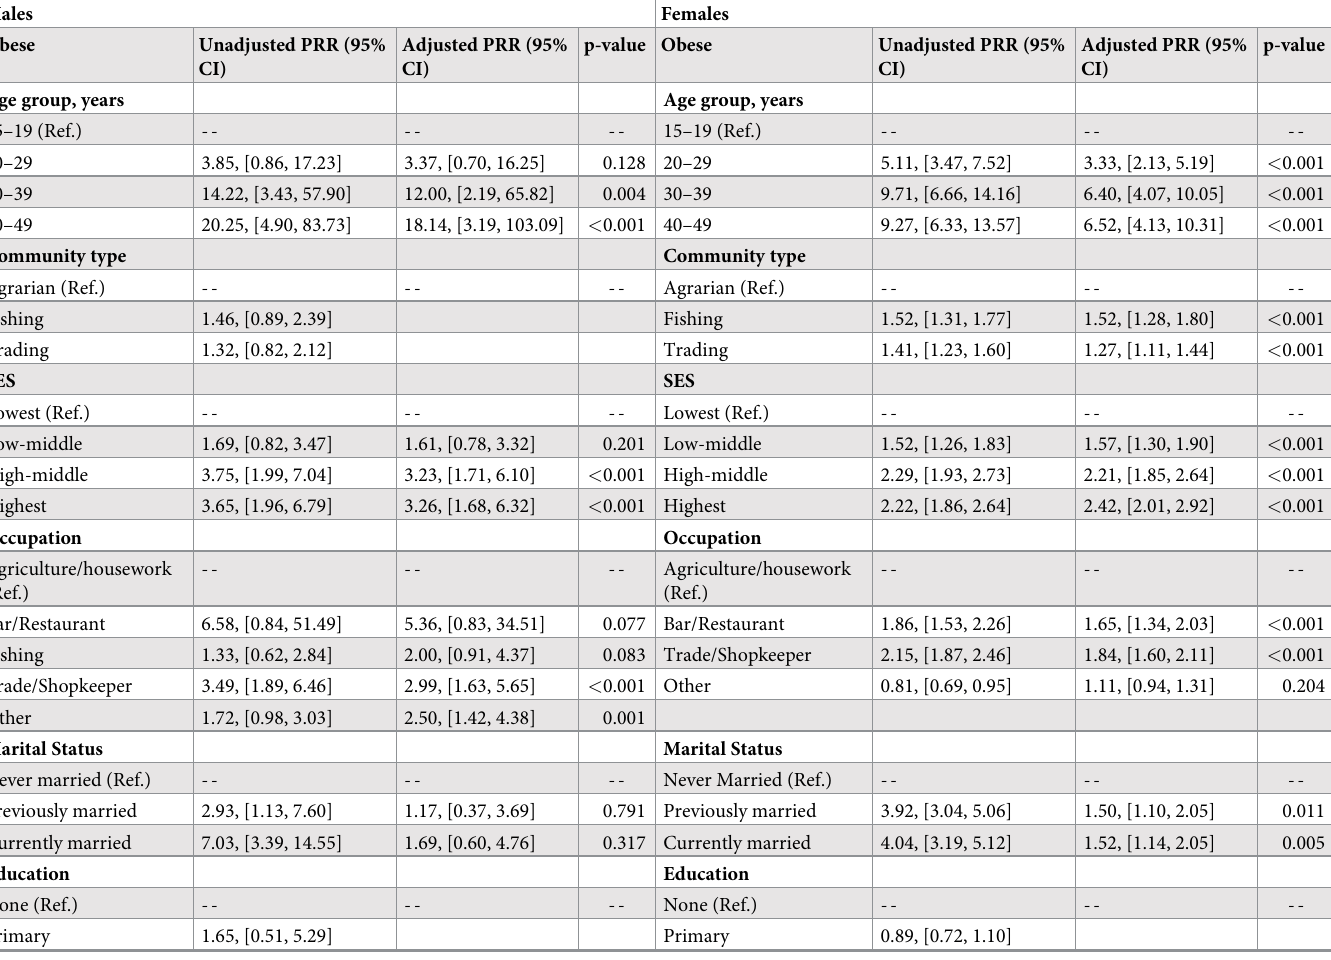
Table 6. Predictors of obesity from adjusted and unadjusted multivariable analysis models for male and female participants.